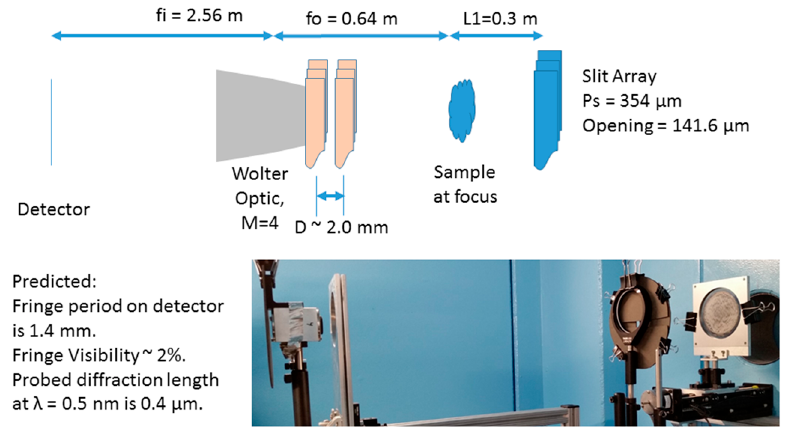
Figure 3. Schematic and photo of the WOOFF experiment. The beam propagates from right to left. The two phase gratings are visible followed by the optics. The detector is beyond the edge of the photograph.